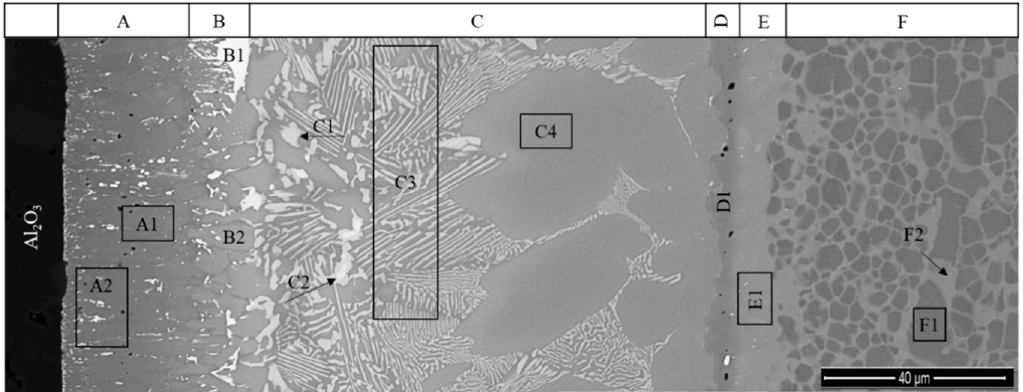
Figure 3. SEM image of Al 2 O 3 / γ -TiAl alloy interface with indication of the EDS analyzed zones in the reaction layers ( A – F ) of the interface .